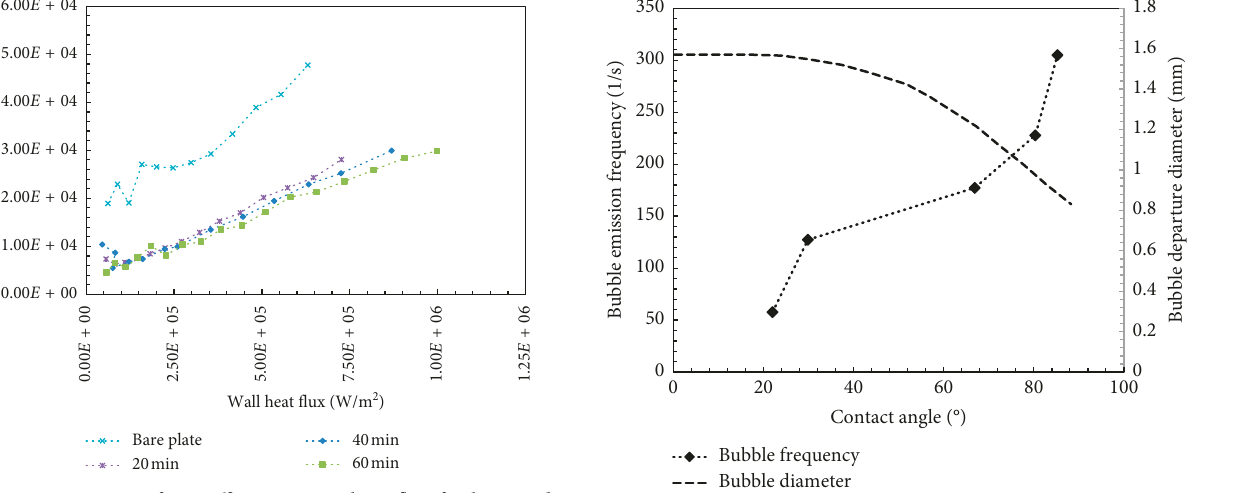
Figure 11: Heat transfer coefficient versus heat flux for bare and coated plates.